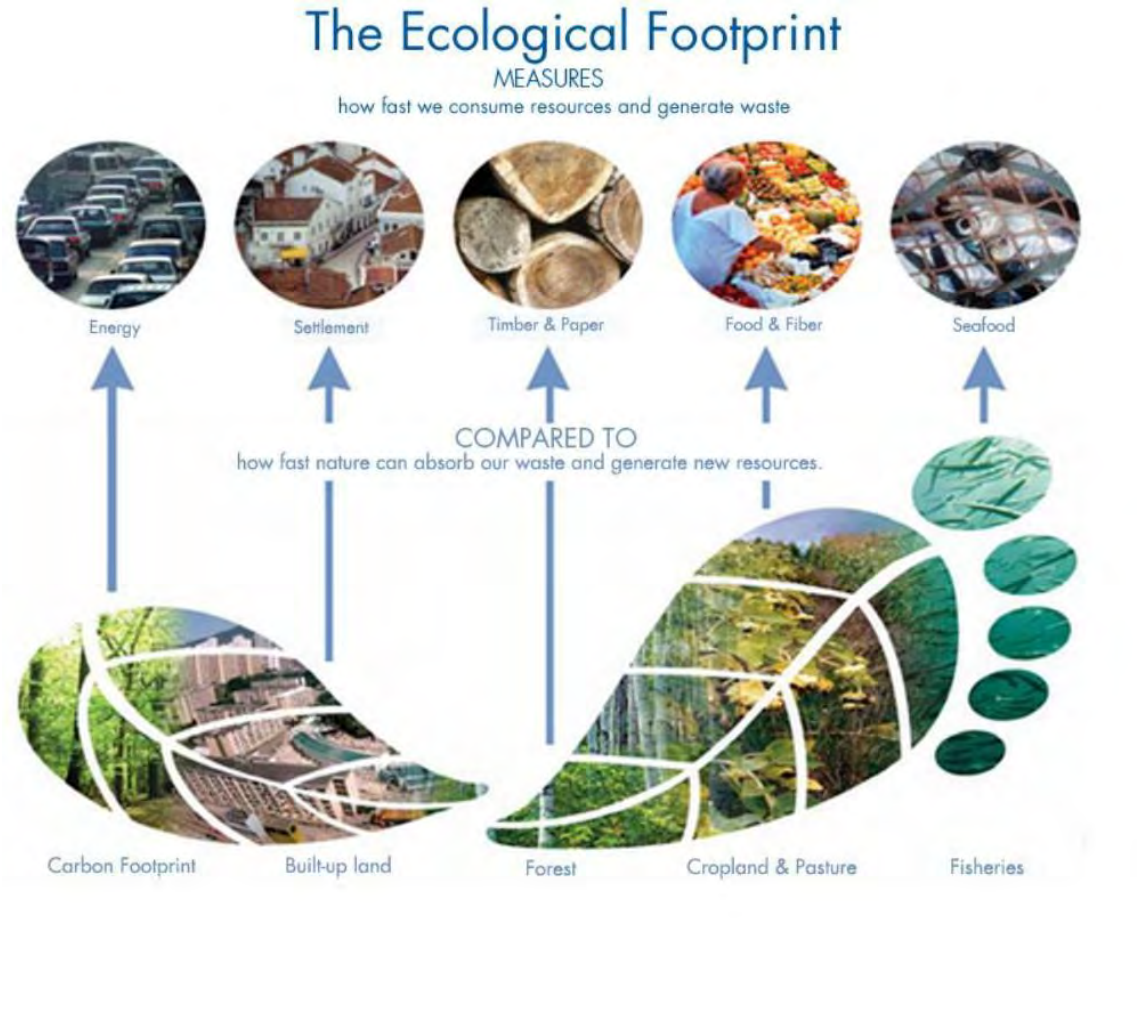
Figure 4. An illustration of the ecological footprint (”Global Footprint Network”,